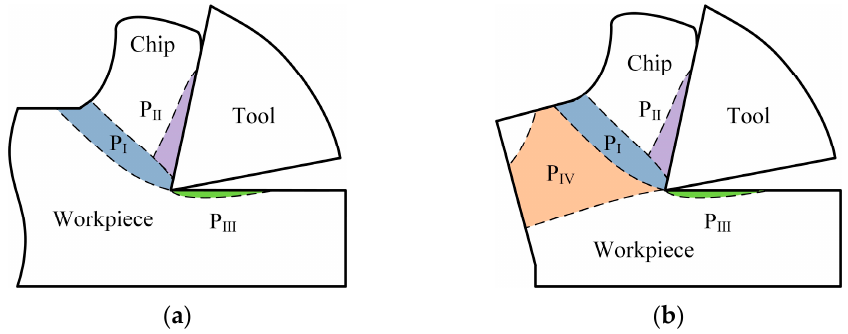
Figure 3. Schematic of negative shear deformation zone. ( a ) Three basic deformation zones. ( b ) The fourth deformation zone.